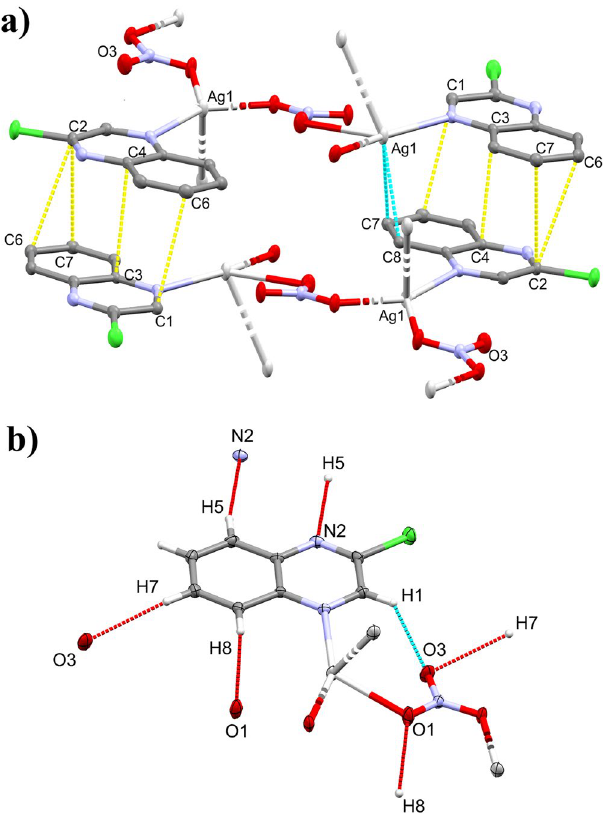
Figure 5. Crystal packing of 1 via C…C (yellow), Ag…C (light blue) interactions ( a ) and hydrogen bond contacts ( b